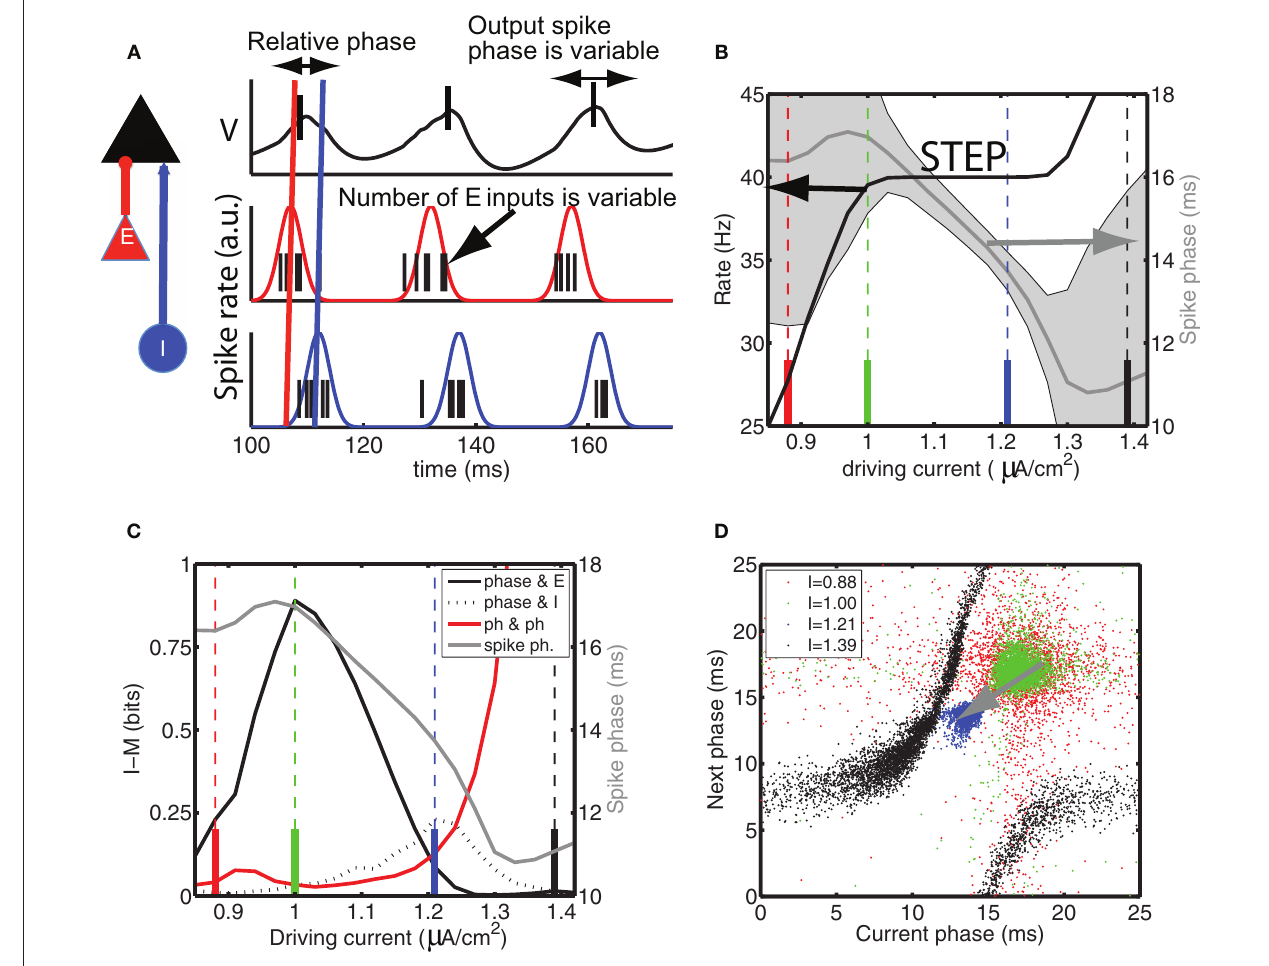
current. Specifically, for higher current values the spikes appeared earlier in the cycle. (C) , black curve, left hand-side axis) The mutual information IM, between the number of E inputs on a given cycle and the resulting spike phase, attained its maximum at the low current value of the step and decreased when the driving current was increased. In contrast (dashed black curve), the mutual information between the number of I inputs and spike phase and (red curve) mutual information between consecutivespikes phases increased with driving current. For comparison, the mean phase is re-plotted from (B) as the gray curve. The colored vertical lines indicate the current values for which the return map is shown in (D) . (D) The spike phase varies from cycle to cycle because of the variation in the number of E and I inputs on a cycle and the state of the neuron, the latter of which is partially reflected in the value of the previous spike phase. The return map shows the correlation between consecutive phases. The color of the dots corresponds to the current value indicated by the colored vertical lines in (B,C)